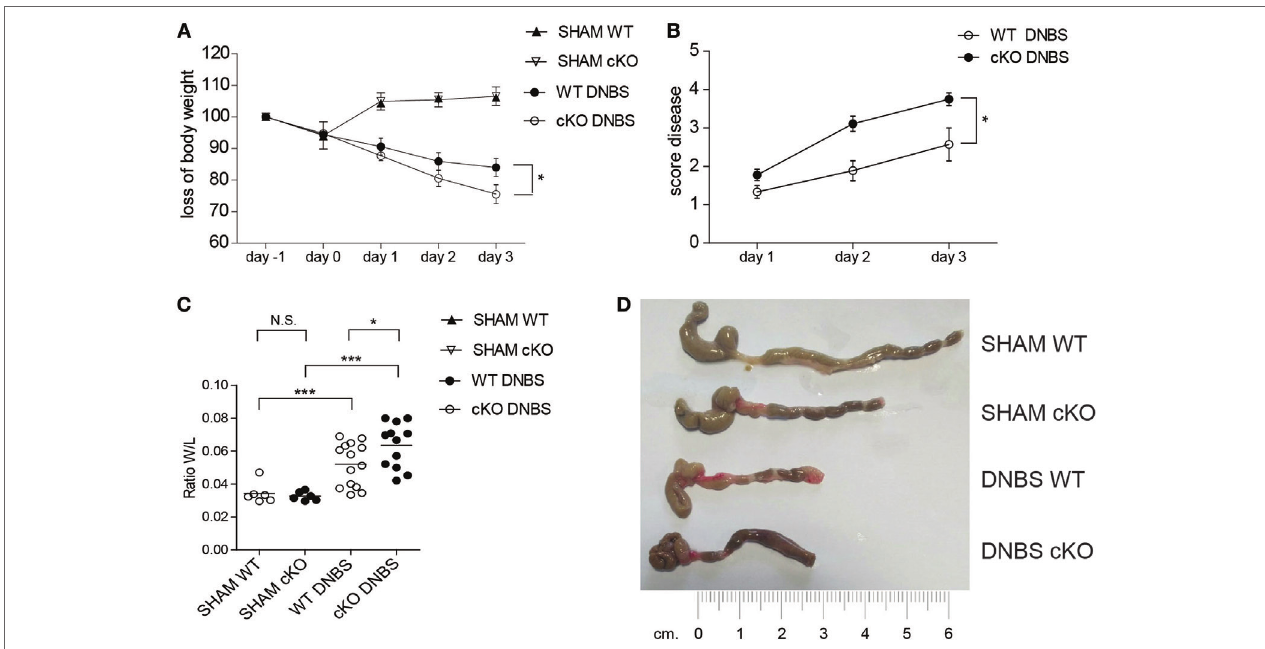
FigUre 5 | Lack of glucocorticoid-induced leucine zipper (GILZ) exacerbates 2,4-dinitrobenzene sulfonic acid (DNBS)-induced colitis. (a) Loss of body weight in wild-type (WT) and gilz B cKO mice treated intrarectally with vehicle (Sham) or DNBS. (B) Daily measurement of total disease score in WT and gilz B cKO mice during DNBS-induced colitis. (c) Colon weight/length ratio of WT and gilz B cKO mice intrarectally administered with vehicle (Sham) or DNBS. (D) Representative macroscopic images of the colon of WT and gilz B cKO mice intrarectally administered with vehicle (Sham) or DNBS are shown ( n = 9). Statistical analysis was performed using the unpaired Student’s t -test (* p < 0.05, *** p <